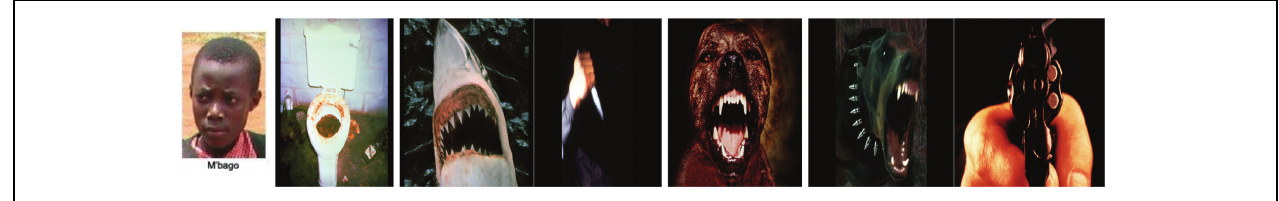
FIGURE 5 | Example of stimuli used in Study 5b.